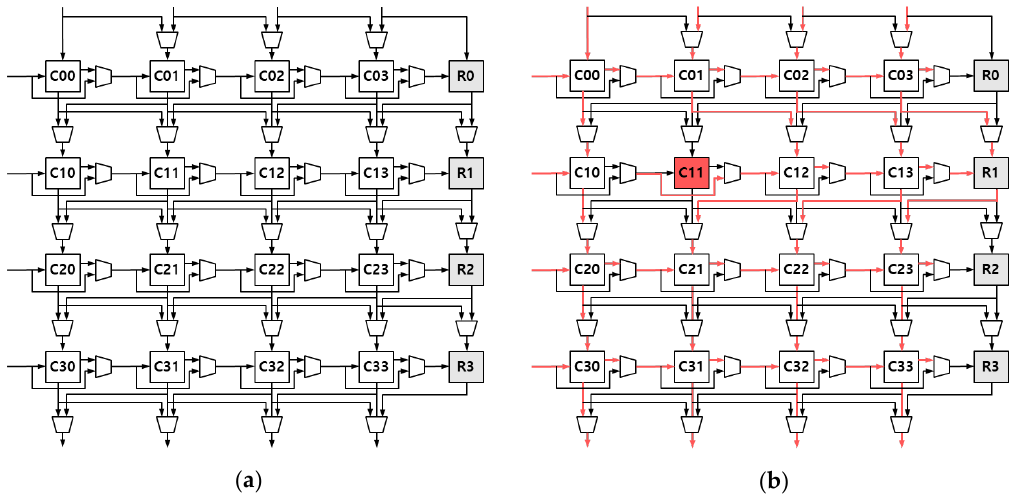
Figure 2. Previous systolic-array redundant architecture [12]: ( a ) Overview; ( b ) Repair